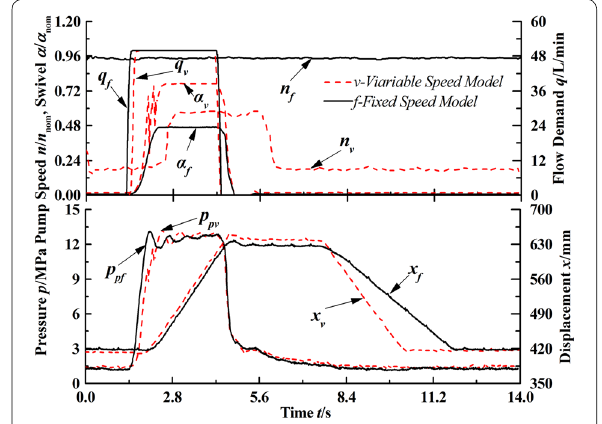
Figure 13 Actual speed and swivel of the pump